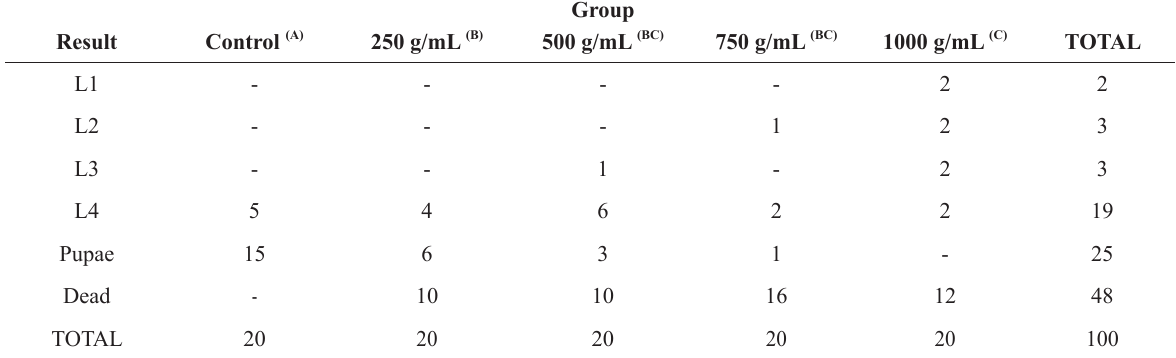
Evaluation of embryotoxic and embryostatic effects of aqueous extract of R. mangle in A. aegypti larvae over 14 days